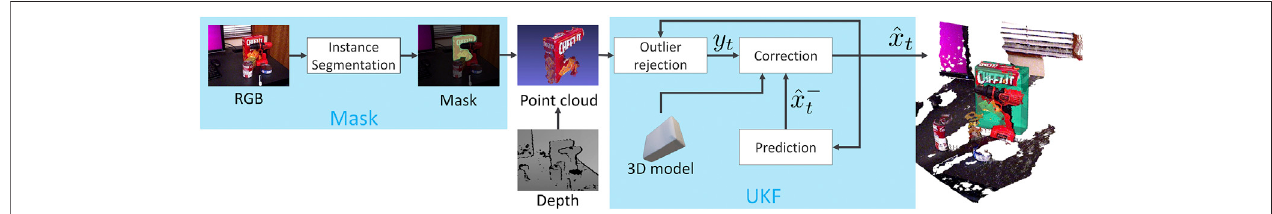
FIGURE 1 | Illustration of our MaskUKF framework for 6D object pose tracking. For each RGB-D frame, a generic instance segmentation algorithm provides the segmentation mask of the object of interest. The mask is combined with the depth frame to produce a partial point cloud of the object that is further re fi ned to remove possible outliers. The resulting measurements are fed into an Unscented Kalman fi lter to update the belief of the object pose and velocity.